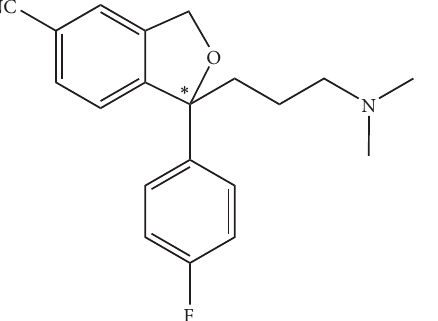
Figure 2: Structure of SBE- 𝛽